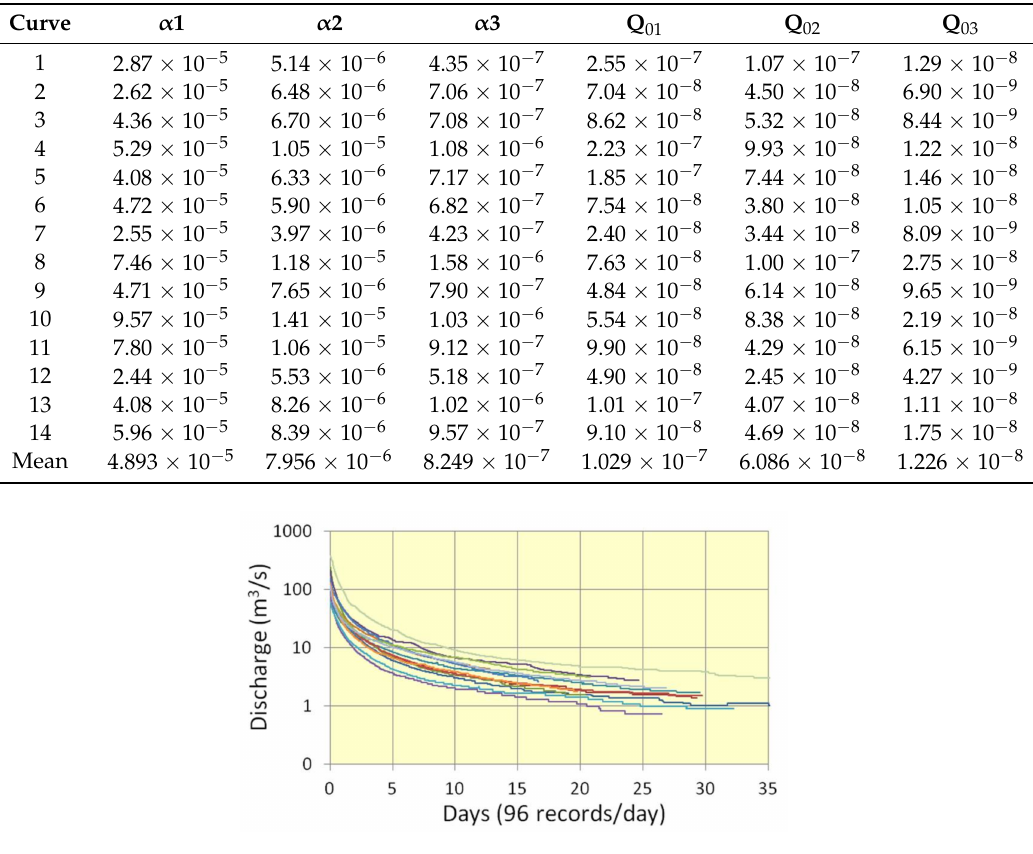
Figure 3. Recession curves (14) selected for the calibration of